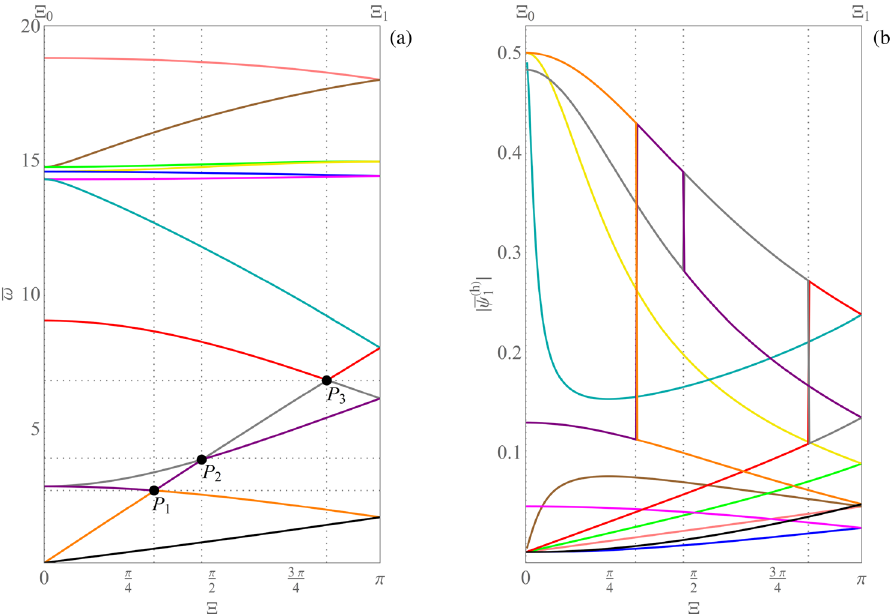
Figure 7. ( a ) Dispersion curve coloring obtained by the alternative simple method. ( b ) Loss of continuity of the ( h ) | corresponding to the generalized eigenvector curves, labeled in accordance with magnitude components | ¯ ψ 1 the results reported in part ( a ) of the figure.